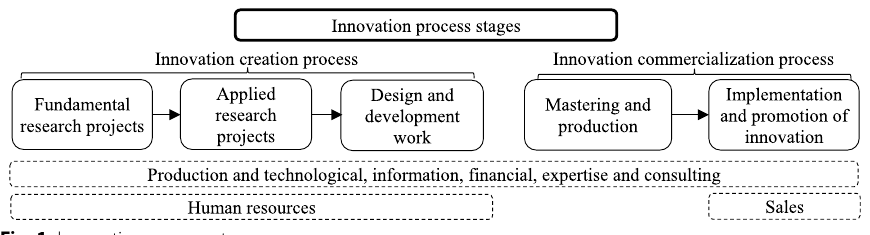
Fig. 1 Innovation process